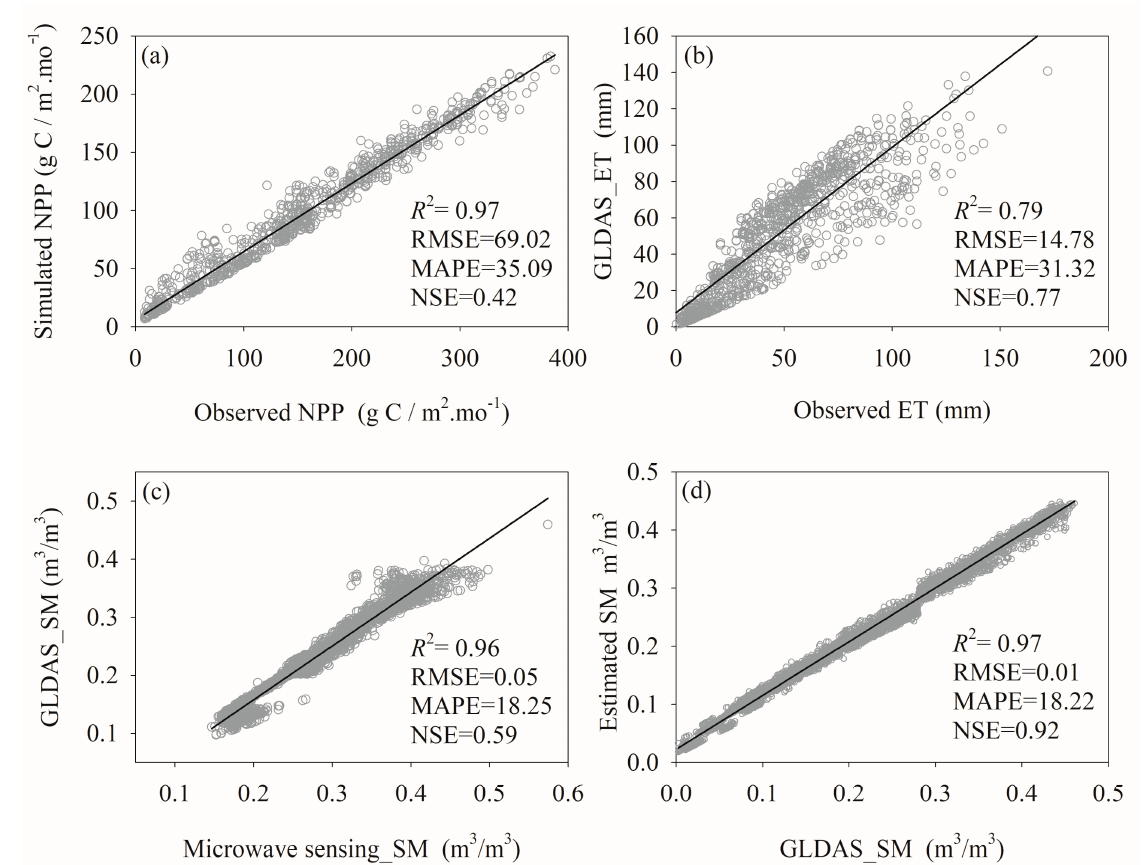
Figure 2. Accuracy verification of net primary production ( NPP ), evapotranspiration ( ET ), and soil moisture data used in this study. ( a ) Scatter plot between the estimated and measured monthly NPP from 12 flux towers from 2003 to 2010; ( b ) scatter plot between the monthly ET data from the Global Land Data Assimilation System (GLDAS) dataset and the measured monthly ET data from 12 flux towers from 2003 to 2010; ( c ) scatter plot between the monthly volumetric soil moisture in the root zone (0–100 cm soil layer) from the GLDAS dataset and the SM dataset based on microwave sensing from 2002 to 2011; ( d ) scatter plot between the estimated (in this study) and GLDAS soil moisture data in the root zone (0–100 cm soil layer) of the study